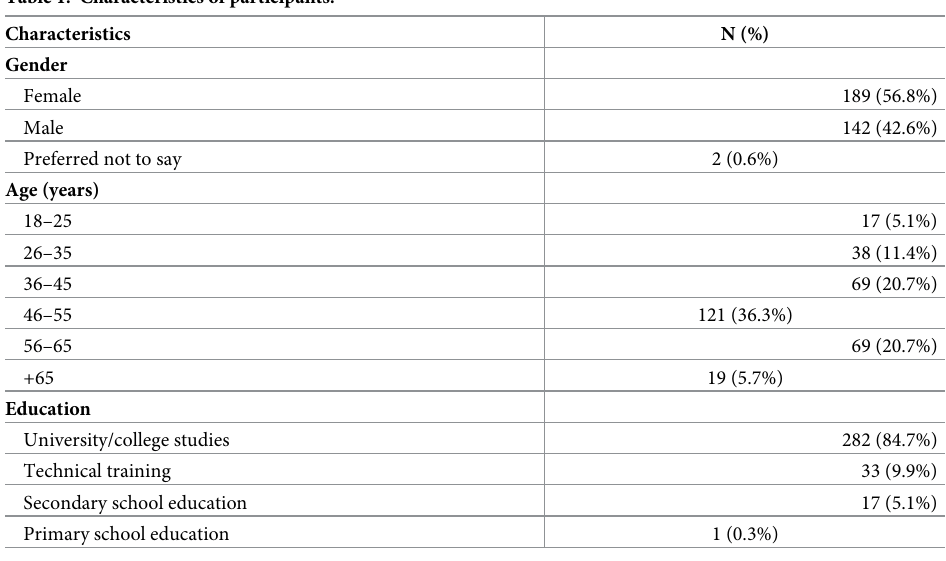
Table 1. Characteristics of